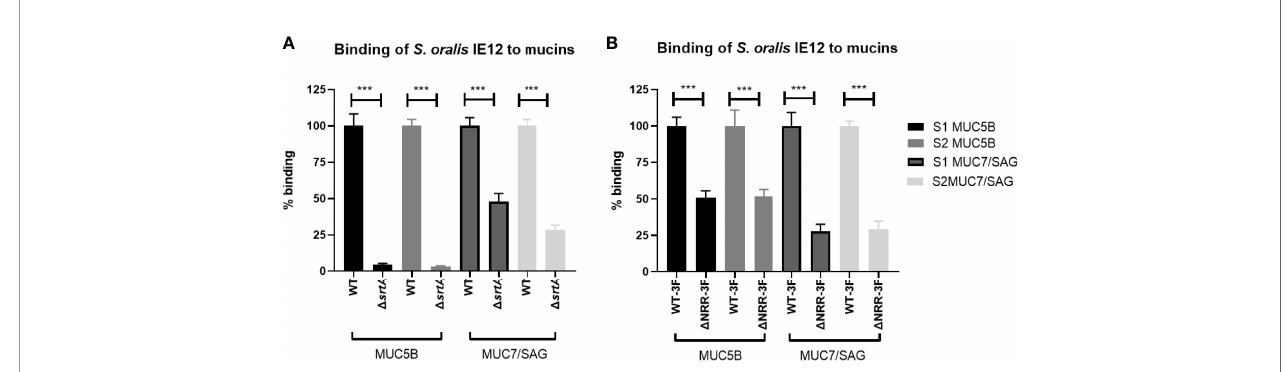
FIGURE 5 | Role of Sortase A and AsaA NRR in S. oralis subspecies oralis binding to salivary mucins. (A) Binding of S. oralis subspecies oralis IE12 WT and an isogenic srtA deletion mutant (IE12 D srtA ) to salivary mucins. IE12 and IE12 D srtA binding to MUC5B rich and MUC7/SAG rich samples from a blood group B donor (S1) and a blood group A donor (S2) was analyzed using a microtiter plate-based assay. The results have been reproduced four times and a representative experiment is shown here. The mean level of binding of IE12 D srtA was always signi fi cantly lower than that of IE12 WT, ranging from 95-98% decreased mean MUC5B binding and 30-70% lower MUC7 binding, depending on sample and experiment. (B) Binding to salivary mucins of S. oralis subsp. oralis IE12- asaA 3F (WT-3F) and IE12 asaA D NRR-3F, an isogenic mutant lacking the sialic acid binding domain of AsaA to salivary mucins. The results have been reproduced three times and a representative experiment is shown here. The mean level of binding of IE12 asaA D NRR-3F was always signi fi cantly lower than that of IE12- asaA 3F, ranging from 26-57% lower MUC5B binding and 12-82% lower MUC7 binding, depending on sample and experiment. Data are presented after subtracting the background control. The bars represent mean ± SEM (n=8), ***p < 0.001; Student ’ s